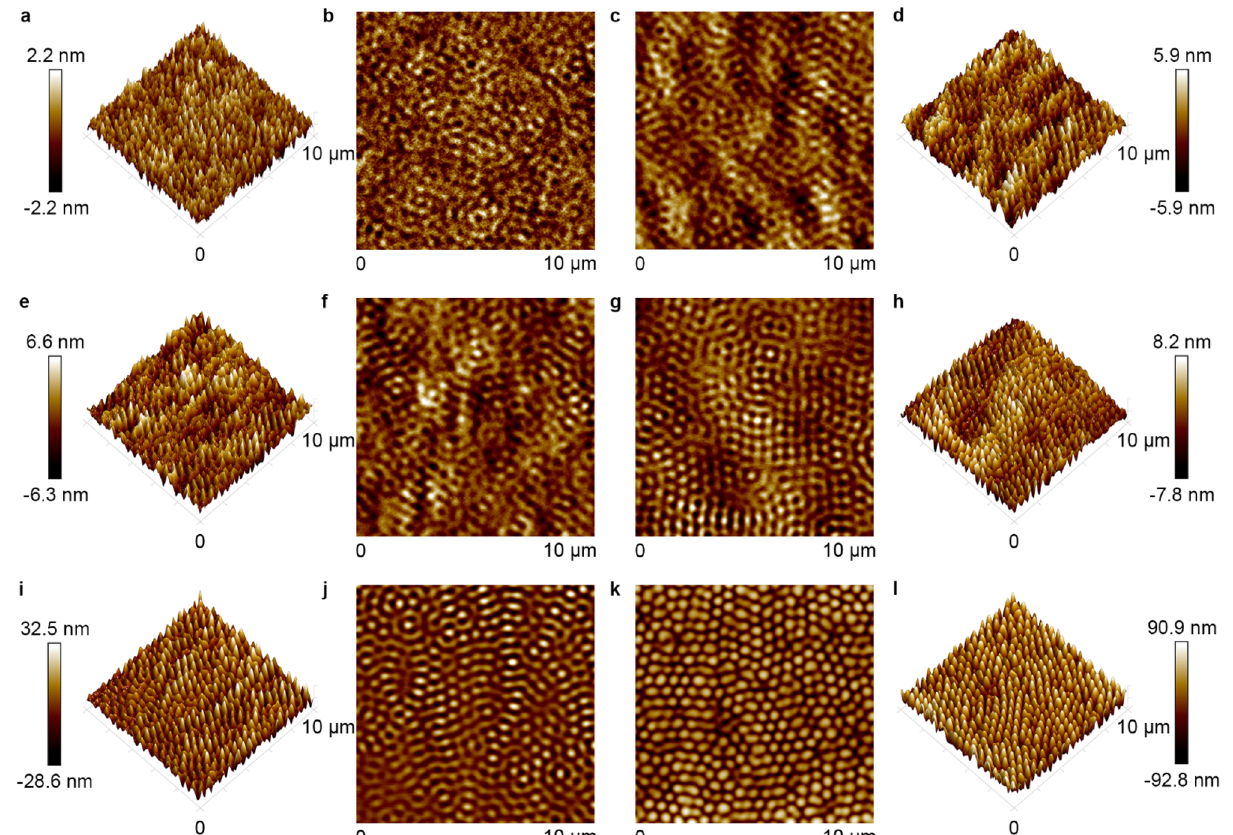
Figure 10. Typical AFM images of the spontaneously formed structures on IA-Chol film after irradiation with the right-hand circularly polarized light for different time periods. ( a, b ) 4 min. ( c, d ) 6 min. ( e, f ) 8 min. ( g, h ) 10 min. ( i, j ) 14 min. ( k, l ) 30 min. The light intensity was 300 mW cm −2